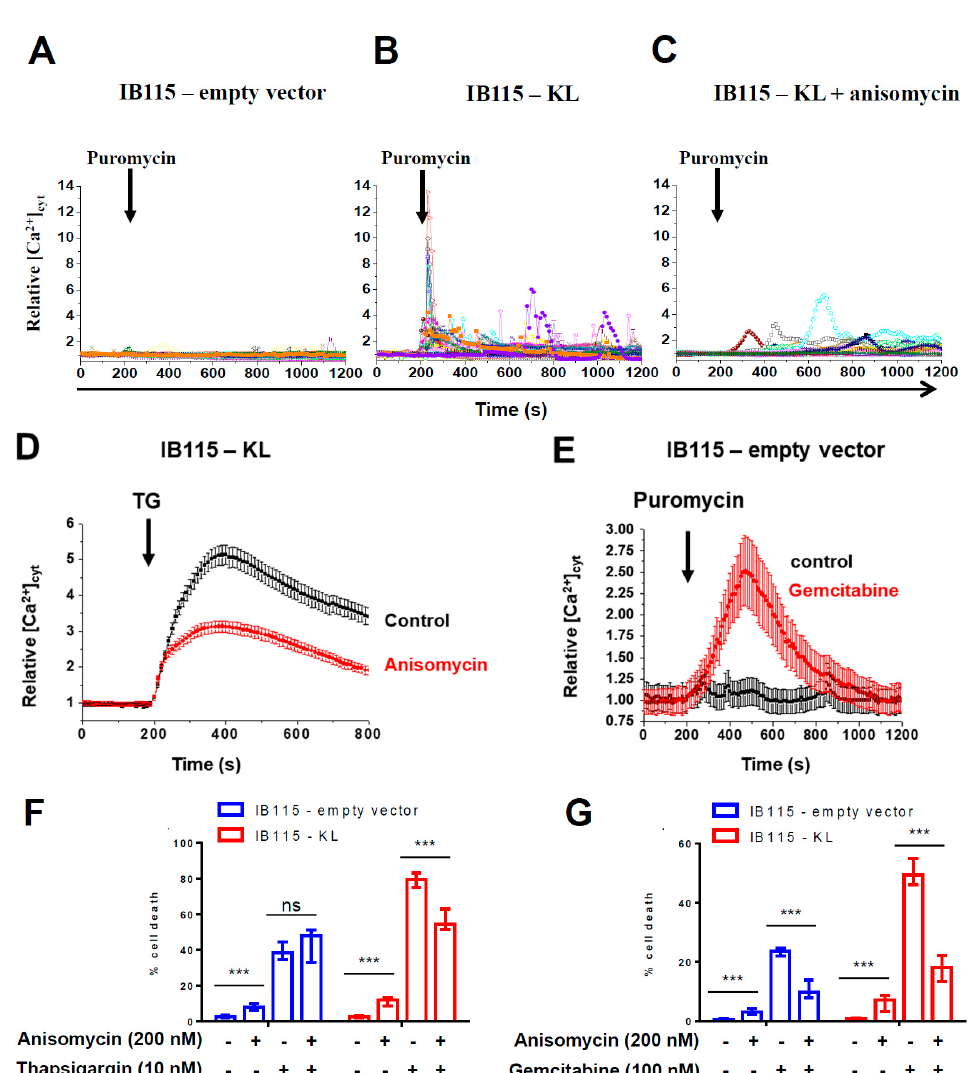
Figure 6. In DDLPS cells, Klotho promotes reticular Ca 2+ -leakage and apoptosis by opening the translocon. ( A – E ) Variations of relative cytosolic Ca 2+ concentration were monitored by fluorescence videomicroscopy in Fluo2-loaded cells. Data shown are representative of three independent